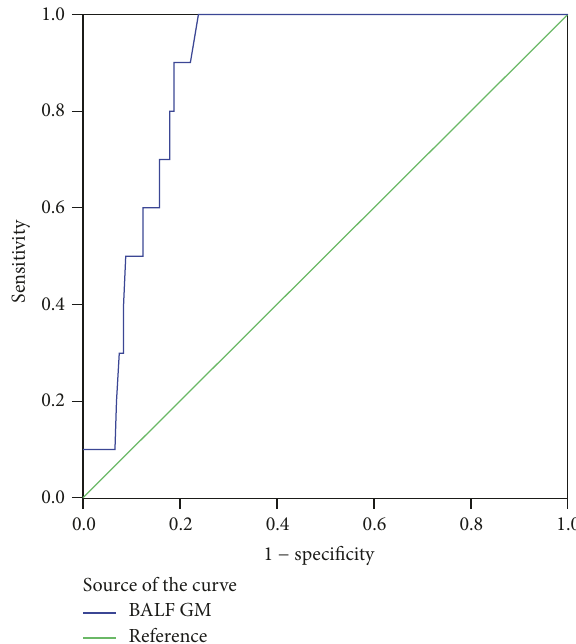
Figure 2: Receiver operating characteristic (ROC) curves for galactomannanassayin183studypopulations.AreasundertheROC curve was 0.88 (95% CI